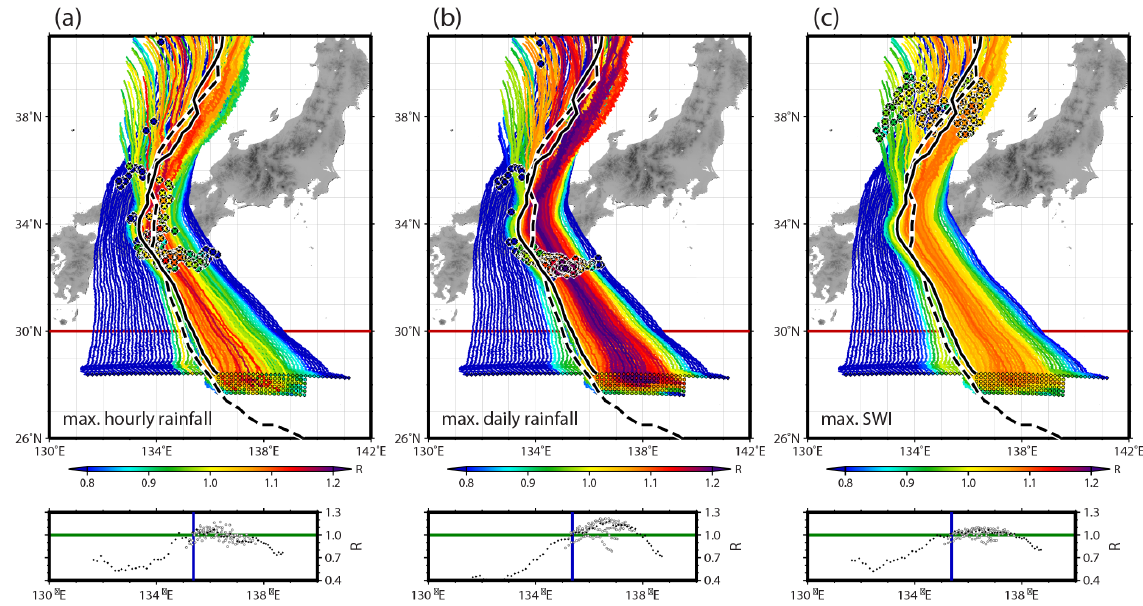
Figure 8. Severity of each ensemble case estimated for different measures: (a) maximum hourly rainfall amount, (b) maximum daily rainfall amount, and (c) maximum soil water index (SWI). The color of the track for each case represents the R score defined by Eq. (6). The crosses indicate the TC location when maximum rainfall or SWI occurs. The filled diamonds (open circles) in the lower panels indicate the R score when each typhoon in a suit of 61 basic members (105 additional members) passed 30 ◦ N, as indicated by the red line in the upper panels. In the lower panels, the green line corresponds to R = 1. The vertical blue line corresponds to the longitude at which the typhoon simulated by NOPVI passed at 30 ◦